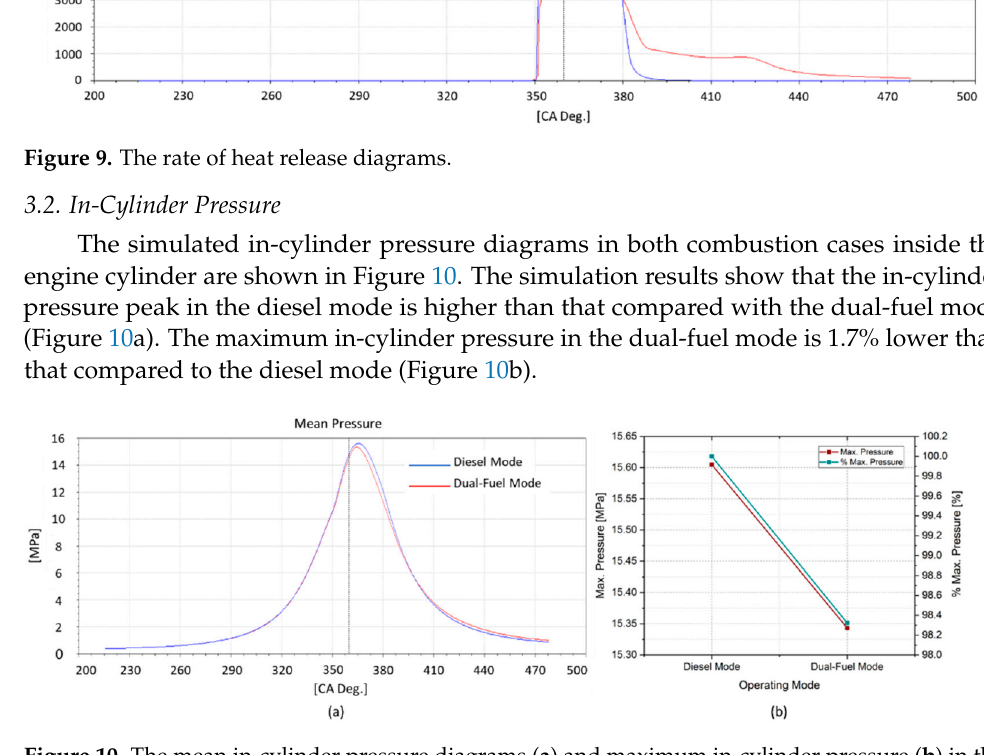
Figure 10. The mean in-cylinder pressure diagrams ( a ) and maximum in-cylinder pressure ( b ) in the two operating